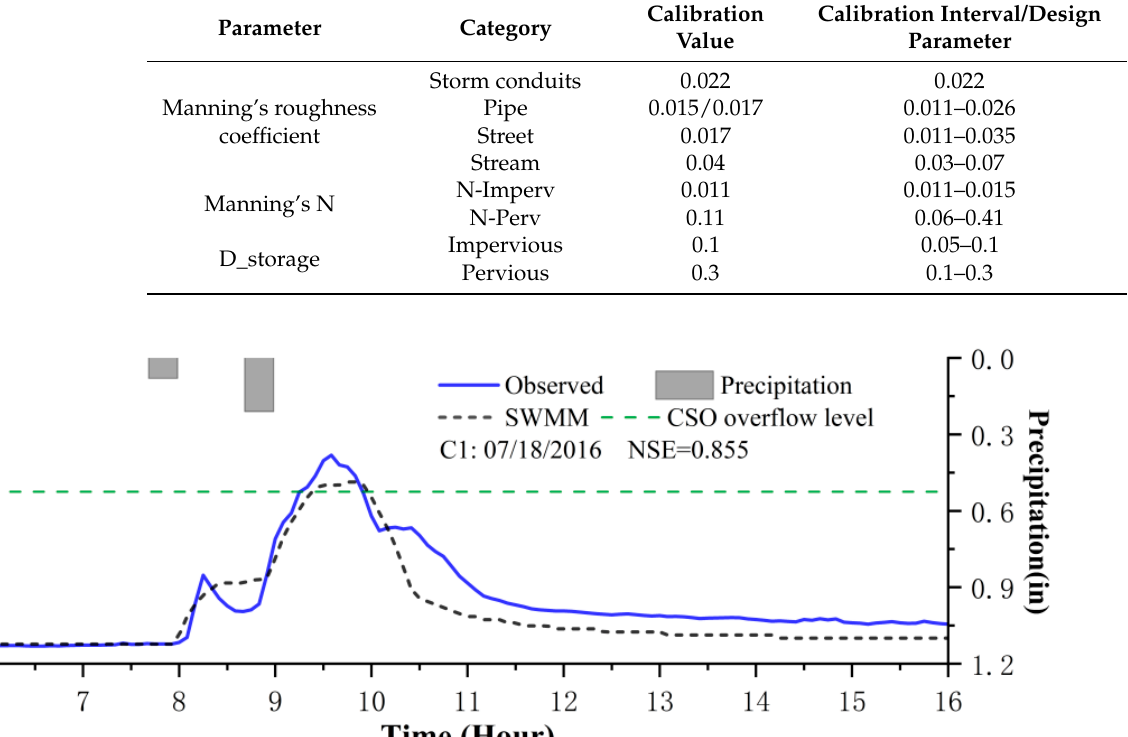
Figure A1. Model